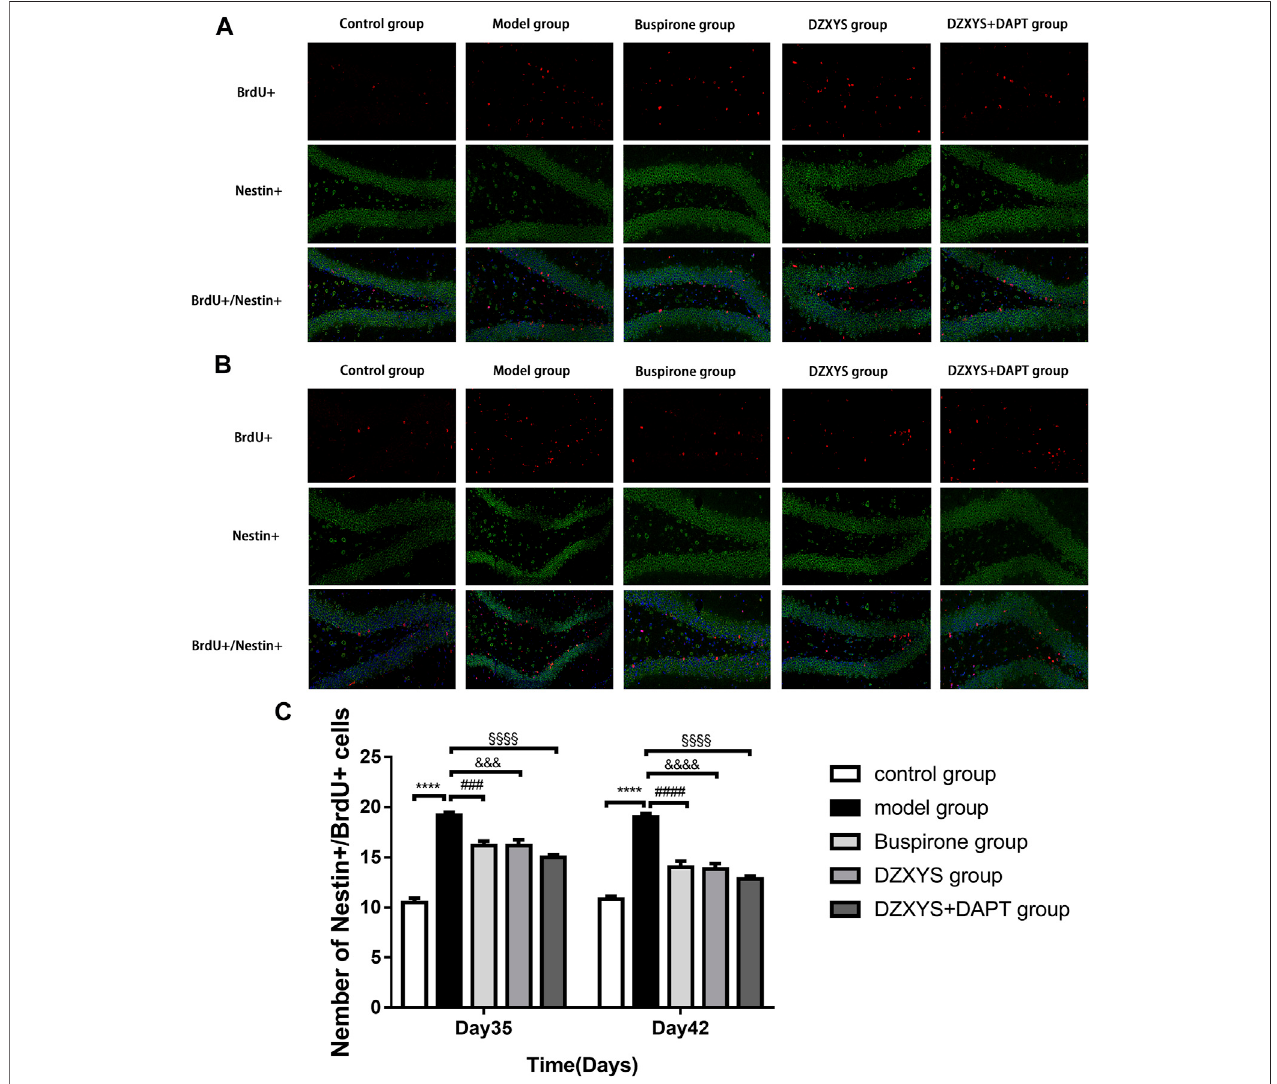
FIGURE 7 | The number of new neural stem cells in the dentate gyrus of hippocampus in each group was shown. BrdU (red) labeled newly formed cells, Nestin (green) labeled neural stem cells. The nuclei were labeled with DAPI (blue) (A) On the 35th day, the number of neural stem cells was increased (B) On the 42nd day, the number of neural stem cells was increased (C) The number of neural stem cell positive cells in dentate gyrus of hippocampus was observed on the 35th and 42nd day.**** p < 0.0001, model group vs. control group; ### p < 0.001, #### p < 0.0001, Buspirone group vs Model group; &&& p < 0.001, &&&& p < 0.0001, DZXYS group vs. model group; §§§§ p < 0.0001, DZXYS + DAPT group vs model group.